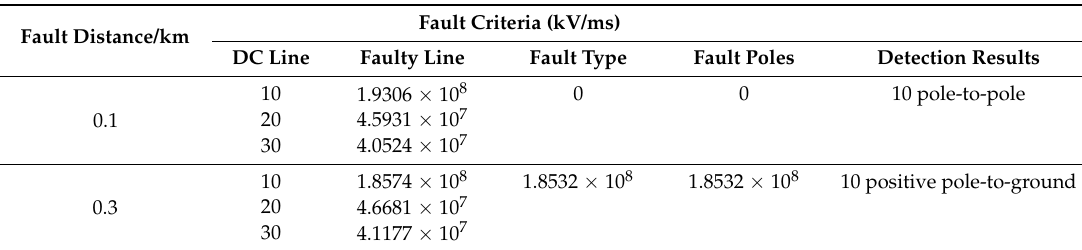
Table 5. Detection results of different fault locations.